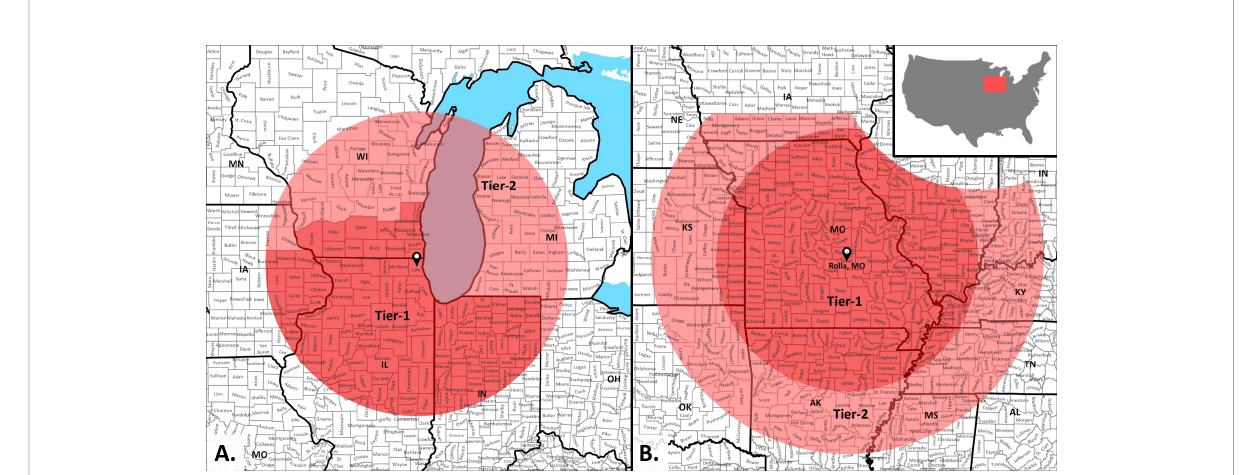
FIGURE 1 Seed procurement speci fi cations from Lake County Forest Preserve District (LCFPD), Illinois, USA. (A) Standard seed sourcing speci fi cation used during the bidding process is biased for seed regionally produced south of Lake County, Illinois which is indicated by the map centroid. The District has a two-tier seed provenance system for purchase consideration of native plant material. Seed sourced by vendors from Tier 1 - (Deep Red) is given priority over seed sourced from Tier 2 (Light Red) during purchasing decisions. (B) Lake County Forest Preserve District has undertaken a test of climate predictive provenancing, with updated Tiers 1 and 2 that were determined by applying Species Distribution Models of multiple species used in standard restoration of abandoned agricultural lands. Overlapping regions between the standard seed provenance (A) and the predictive provenance are cut